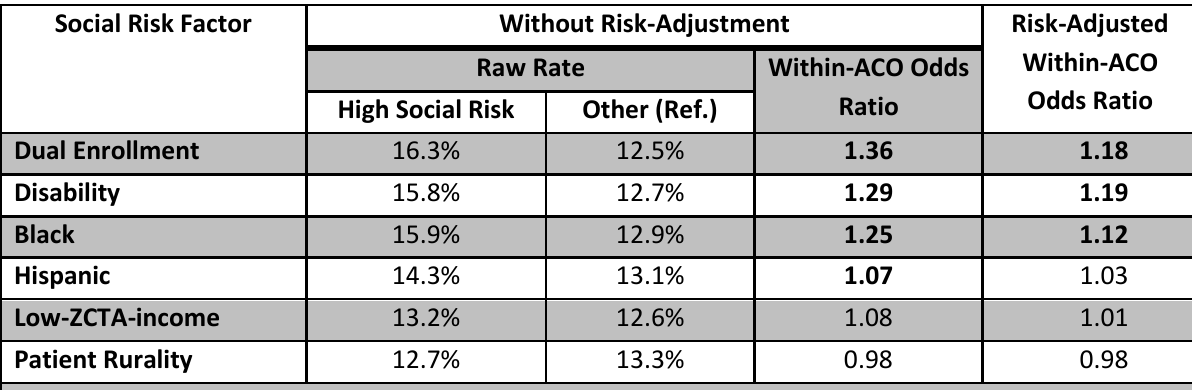
Table 9.3: Beneficiary Social Risk Factors and Performance on Medicare Shared Savings Program Readmission Measure